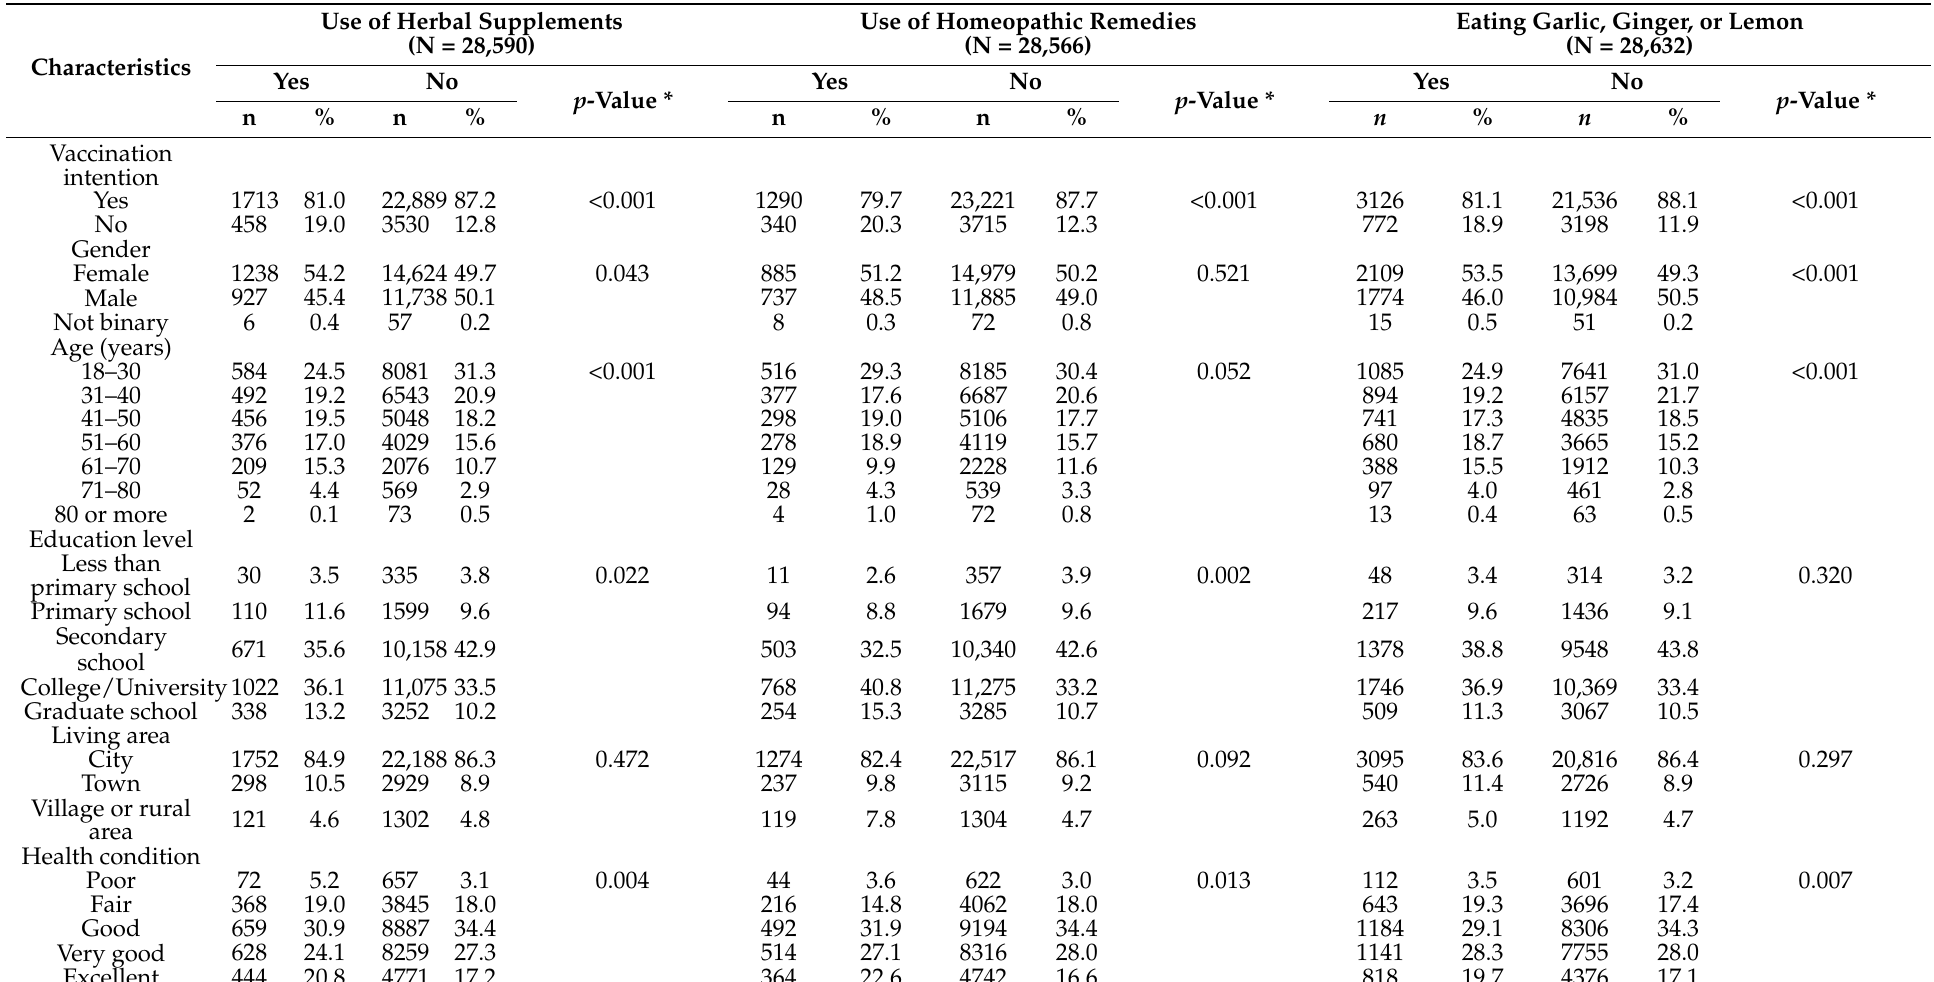
Table 2. General characteristics according to each exposure group to prevent COVID-19 infection in